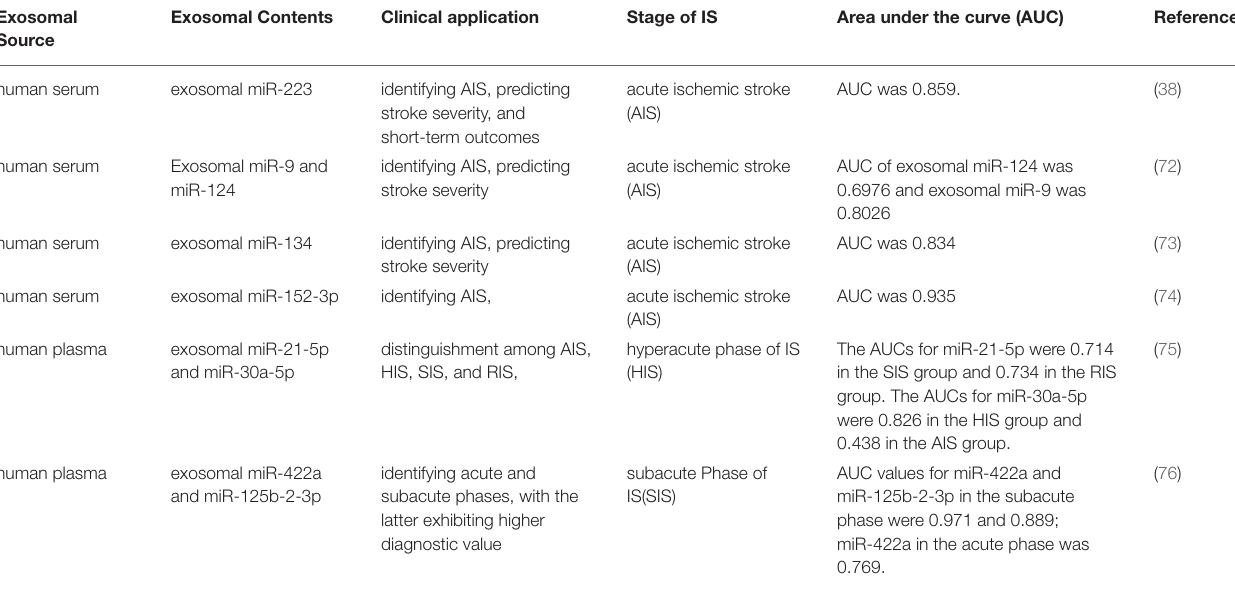
TABLE 1 | Exosomal miRNAs as biomarkers for stroke